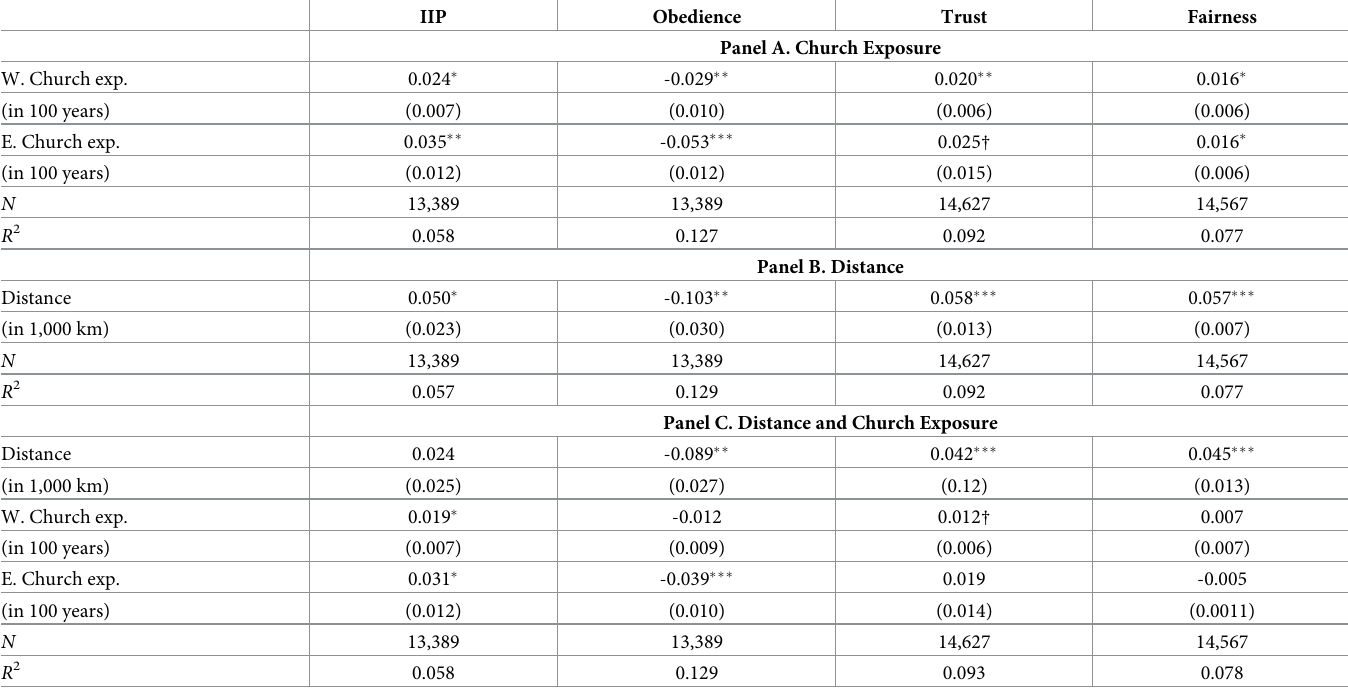
Table 4. Individual-level regressions of psychological outcomes on distance to innovations and Church exposure.